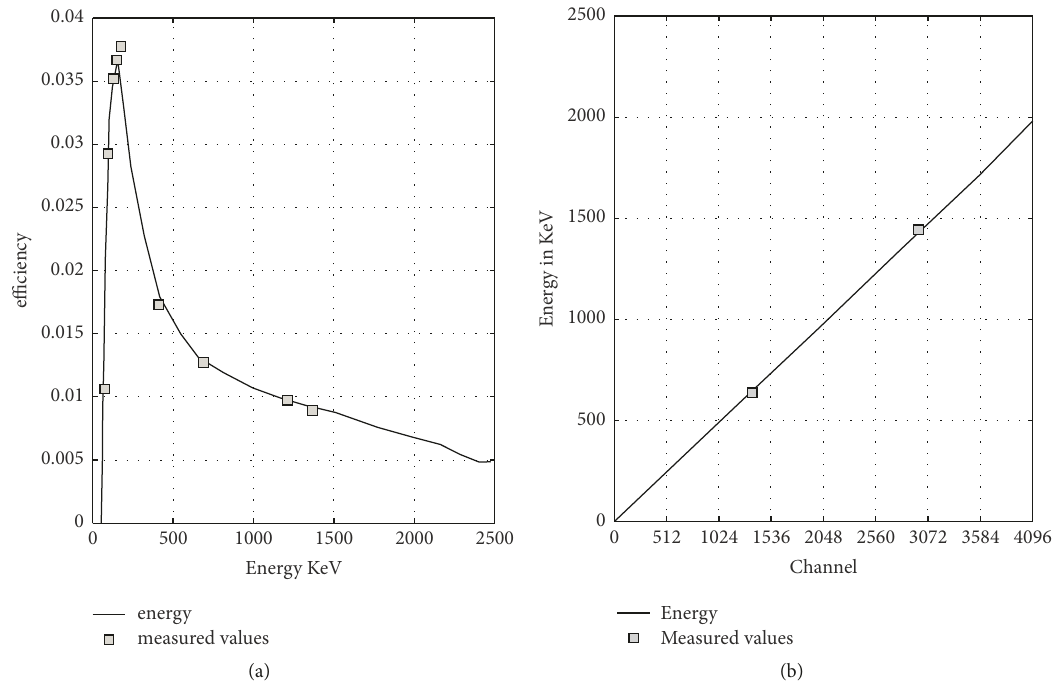
Figure 2: (a) The linear scale of the efficiency calibration curve for HPGe detector (order of the polynomial is 4 with 𝑅 2 = 0.709) . (b) The energy calibration curve for HPGe